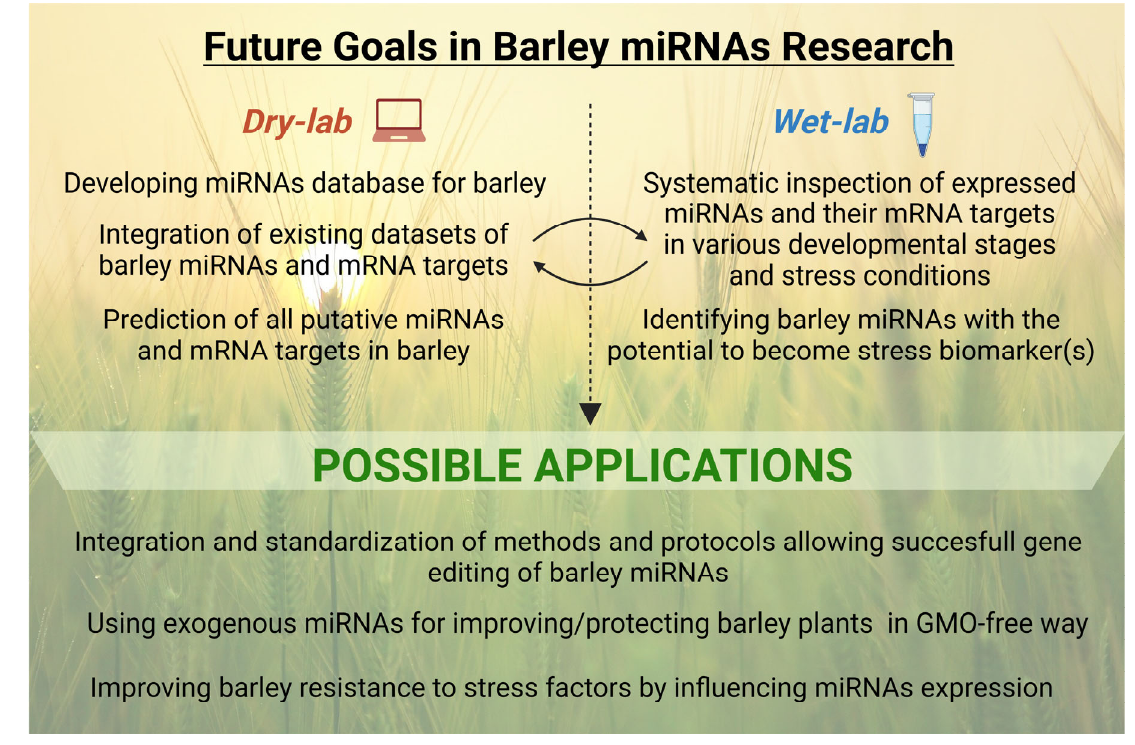
Figure 6. Future goals in miRNAs research in barley, divided into dry-lab and wet-lab categories, and possible future applications.